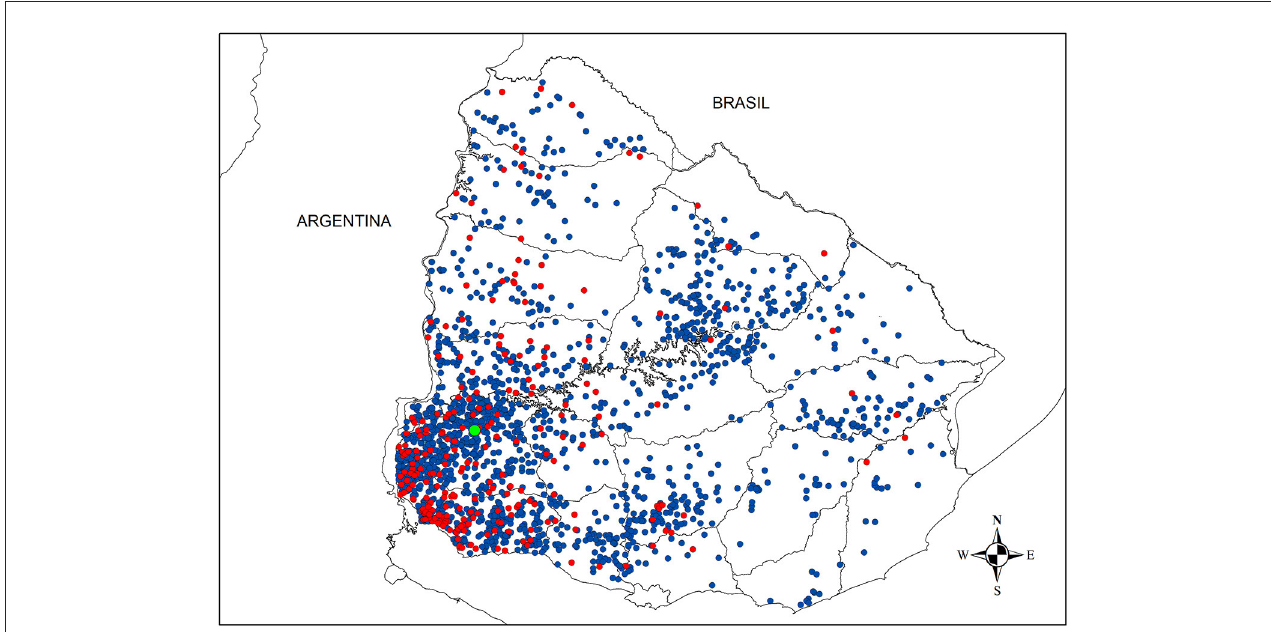
FIGURE2 Spatial distribution of outbreaks. Farms that were infected during the high-risk period (HRP) are represented by red dots, while those infected in the following periods are showed in blue. The HRP corresponds to the period between the FMDV introduction and the index case detection (illustrated by a green